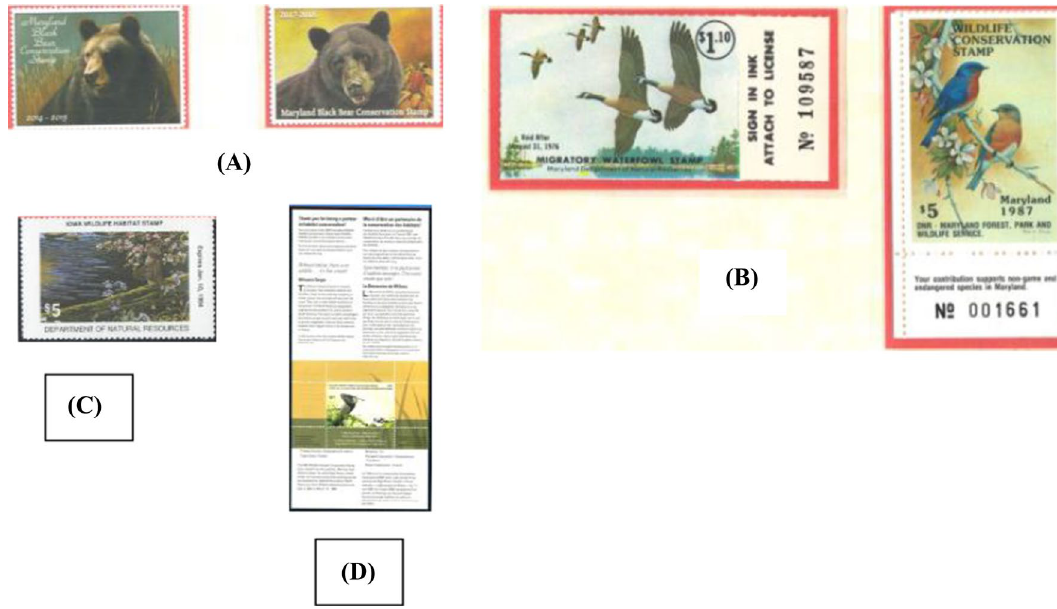
Fig. 3 Examples (not exhaustive) of stamps used for SbRG to meet local biodiversity priorities for conservation as issued by